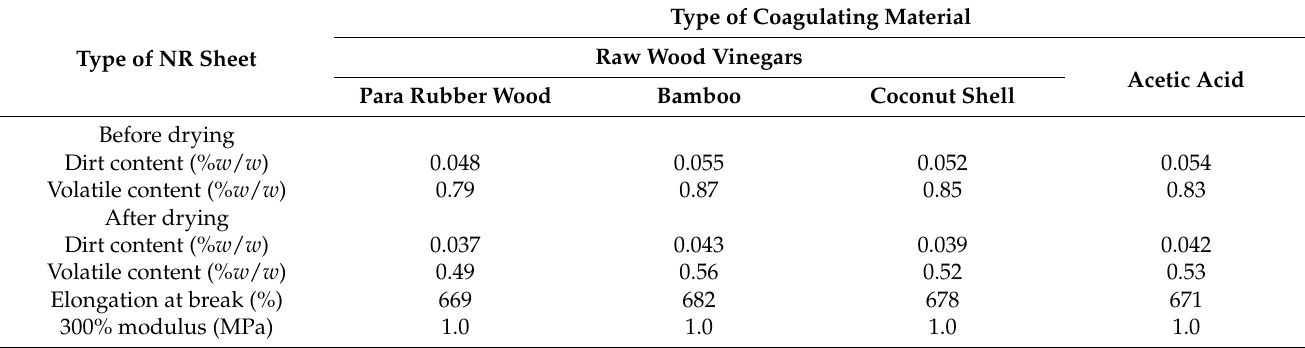
Table 1. The chemical and physical characteristics of the NR sheet results related to the type of coagulating material.